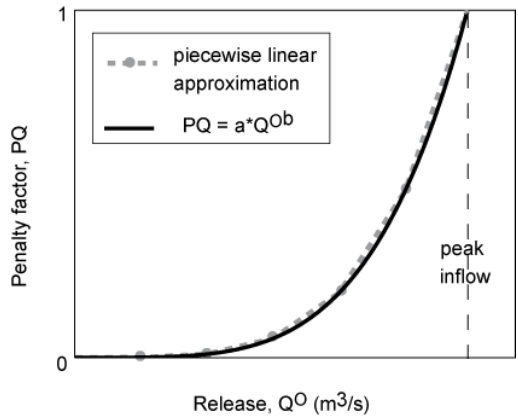
Fig. B1. Example of the released flow penalty curve (solid line) and Figure B1 . Example of the released flow penalty curve (solid line) and piecewise linear 816 piecewise linear approximation (dotted line).